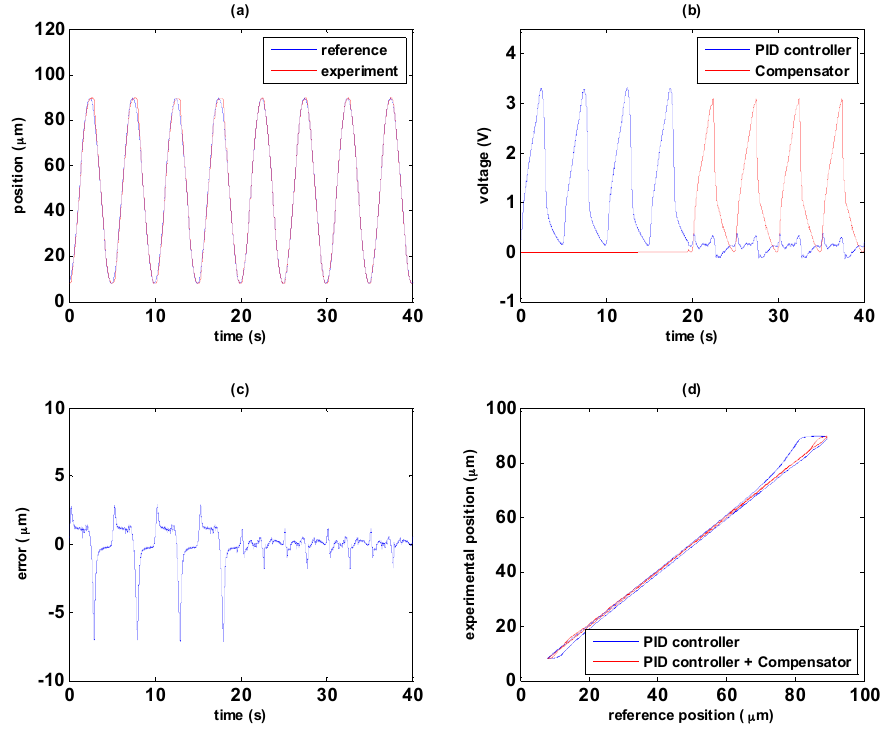
Figure 14. Comparison of PID path control with and without the hysteresis compensator: ( a ) path tracking responses; ( b ) signals of PID controller and the hysteresis compensator; ( c ) control errors; ( d ) linear relationship between reference and experimental positions.